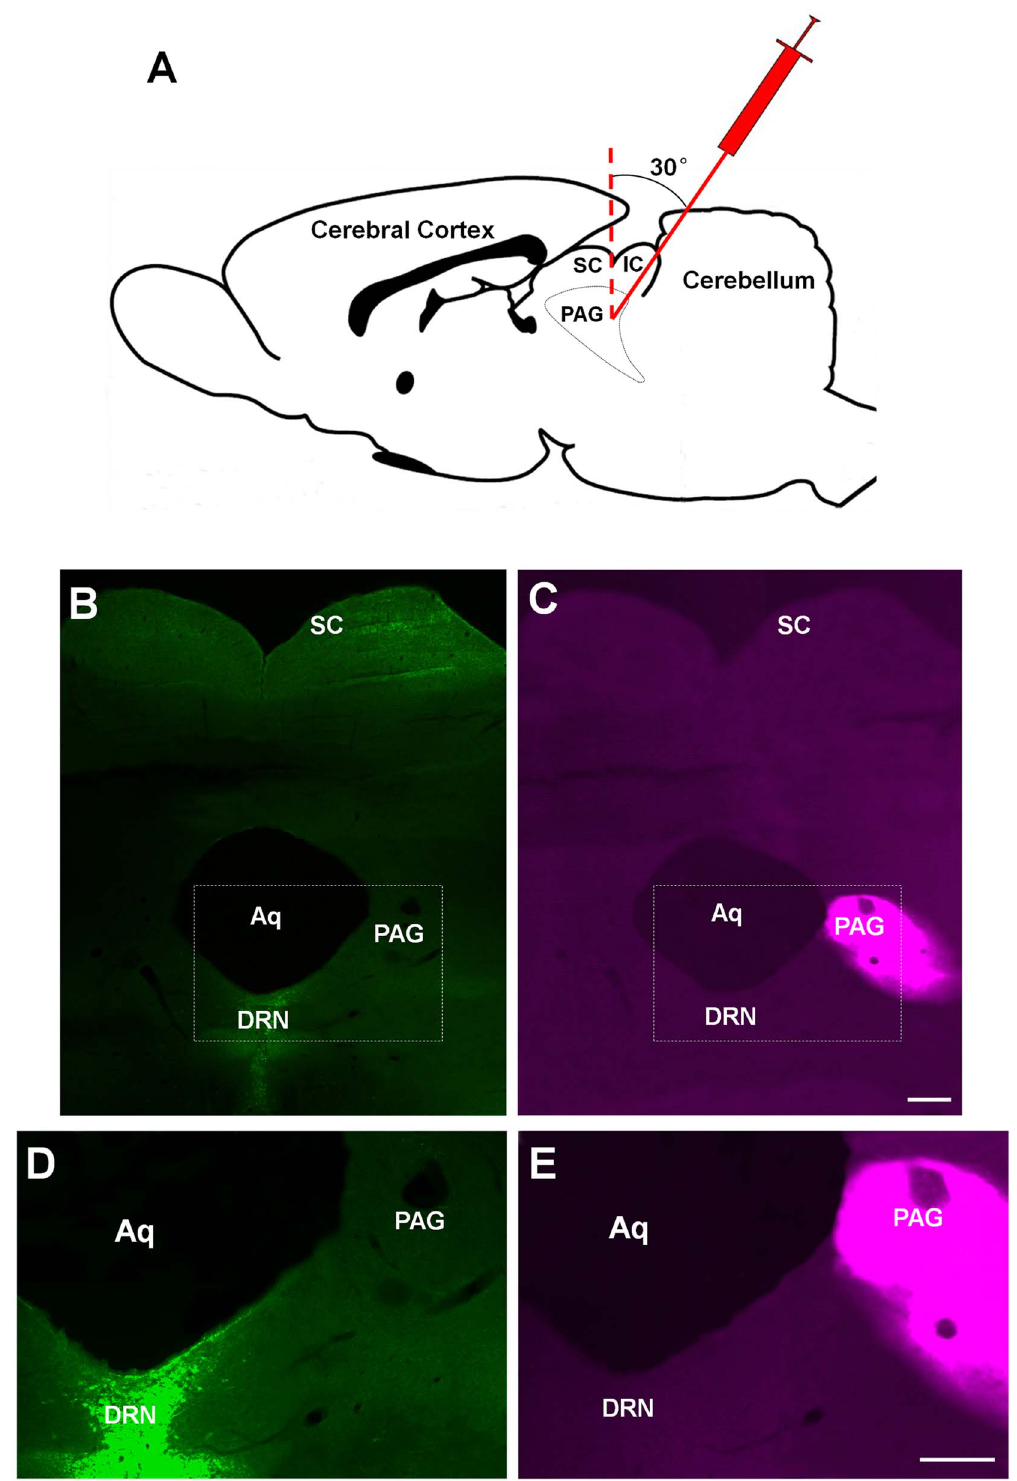
Figure 1. Illustration of the caudal periaqueductal gray (cPAG) injection site. (A) The schematic drawing of Cholera toxin B subunit (CTB) injection. The gray dotted line outlines the border of PAG. Note that to avoid the dye diffusion into superior colliculus (SC), the Hamilton syringe was inclined posteriorly at 30 u angle from vertical and advanced 5.2 mm to target the cPAG. (B–E) A coronal section of the injection site. Trace of injection route is shown in (C) and (E). It is evident that CTB did not diffuse into the superior colliculus (SC) and dorsal raphe nuclei (DRN) (C). Large number of 5-HT + neurons were seen in DRN (green cells in B and D). SC: superior colliculus; IC: inferior colliculus; PAG: periaqueductal gray; DRN: dorsal raphe nuclei; Aq: aqueduct. Scale bars: 300 m m in C (applies to B); 300 m m in E (applies to D).